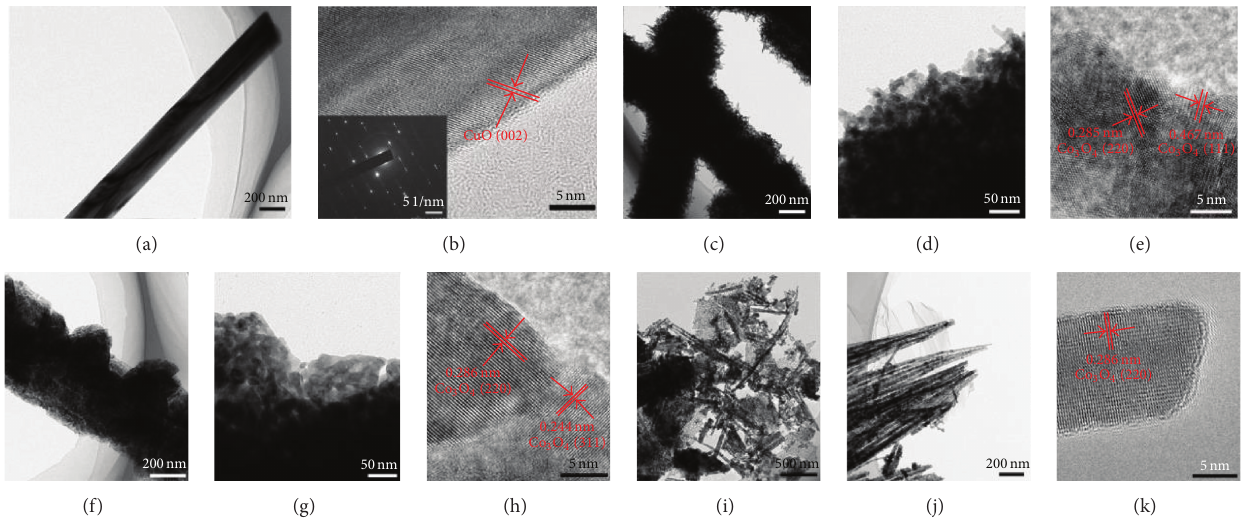
Figure 3: TEM/HRTEM images of CuO NR (a) and (b), (c–e) for CuO/Co 3 O 4 coaxial heterostructures, (f–h) for CuO/Co 3 O 4 nanosheets, and (i–k) for Co 3 O 4